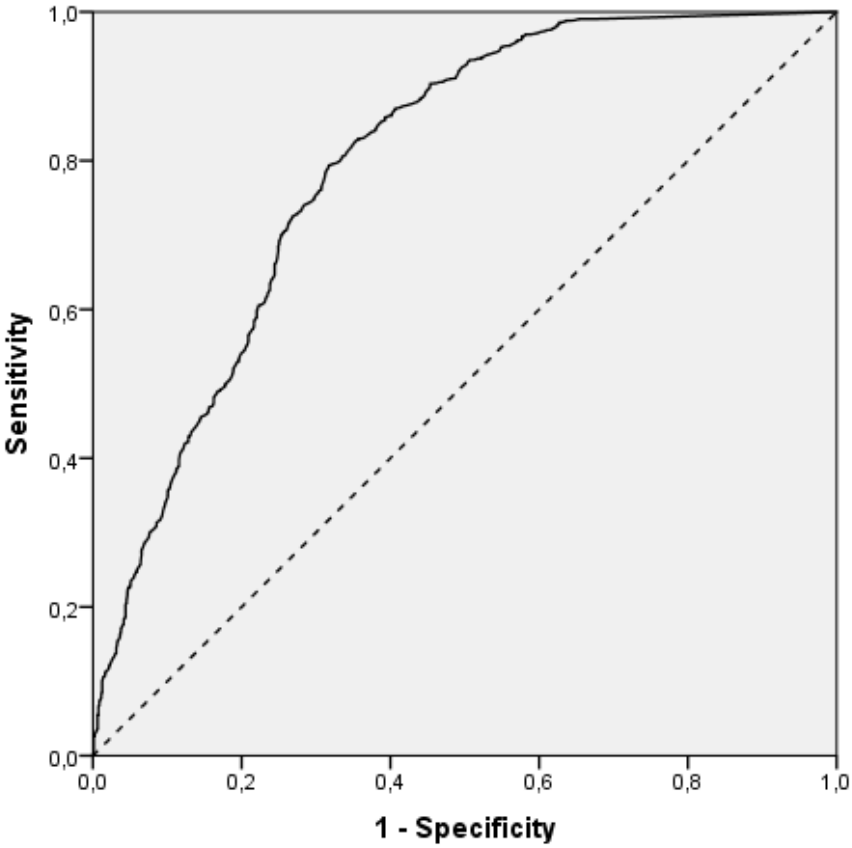
The ROC curve analysis was also used to determine the value of R L for level 3 detection quality with a sensitivity of 95%. The area under the curve in Figure 3 was 0.80, and it was statistically significant ( p < 0.001, 95% CI: 0.78–0.82).